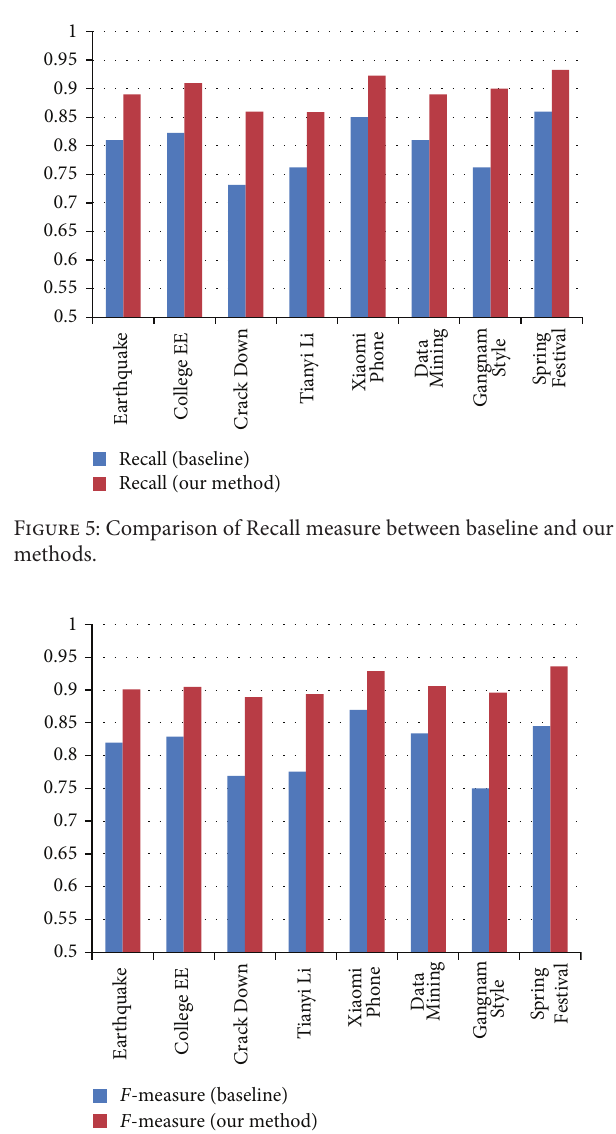
Figure 6: Comparison of F -measure between baseline and our